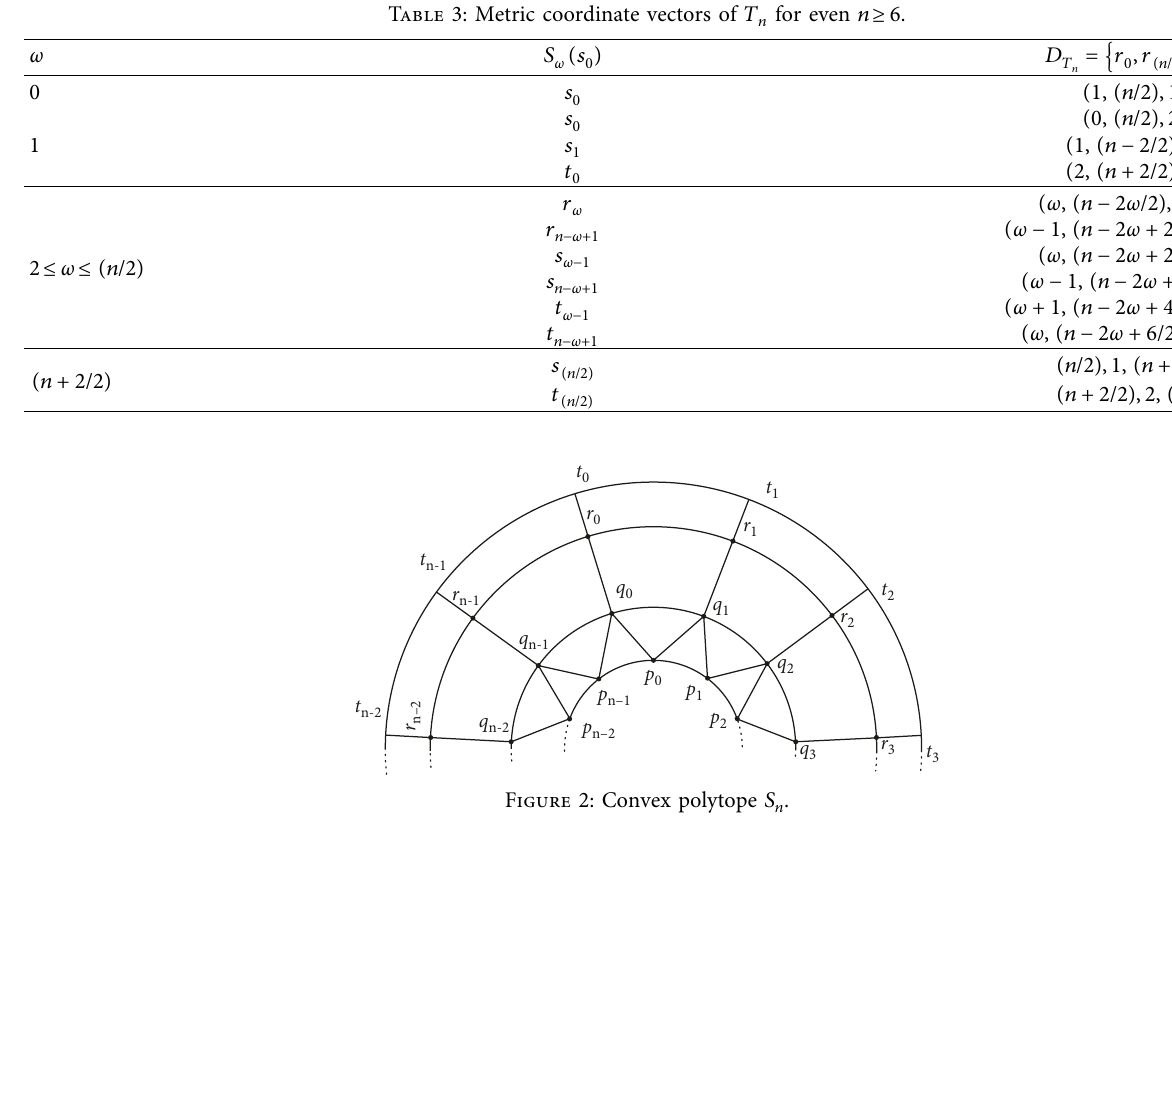
Table 2: Metric coordinate vectors of T